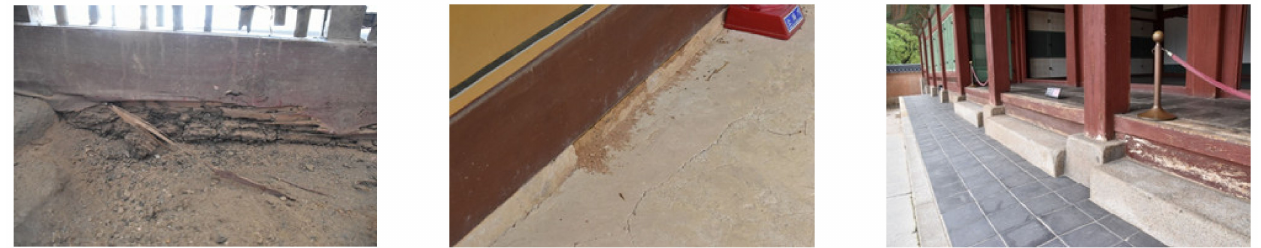
Figure 2. Types of contact between the ground and wooden items in wooden cultural buildings in